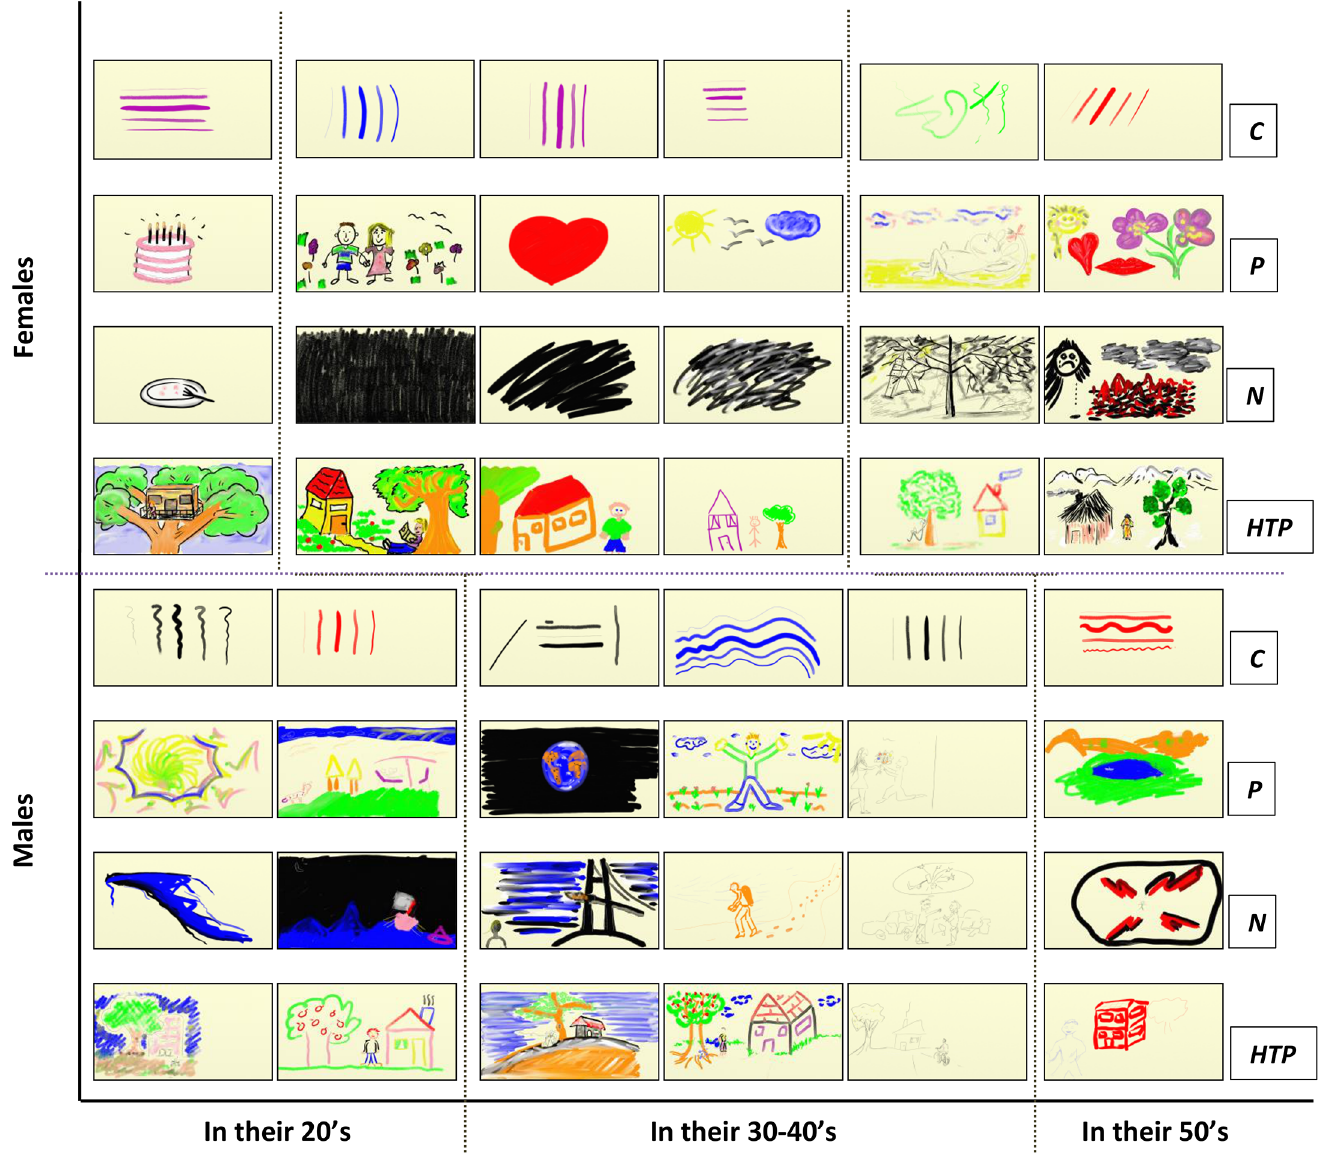
Fig 8. The participants ’ artworks in the study. These are categorized according to the demographic attributes of gender and age. The ordinate is partitioned into males and females and the abscissa into age groups of participants in their 20s, in their 30-40s and in their 50s. The rows corresponding to ( C ) are the artworks of the warm-up calibration drawing task, ( P ) are the artworks of the positive feeling drawing task, ( N ) are those of the negative feeling drawing task, and ( HTP ) are those of the house-tree-person task. Each of the participant ’ s artwork are in his/her respective